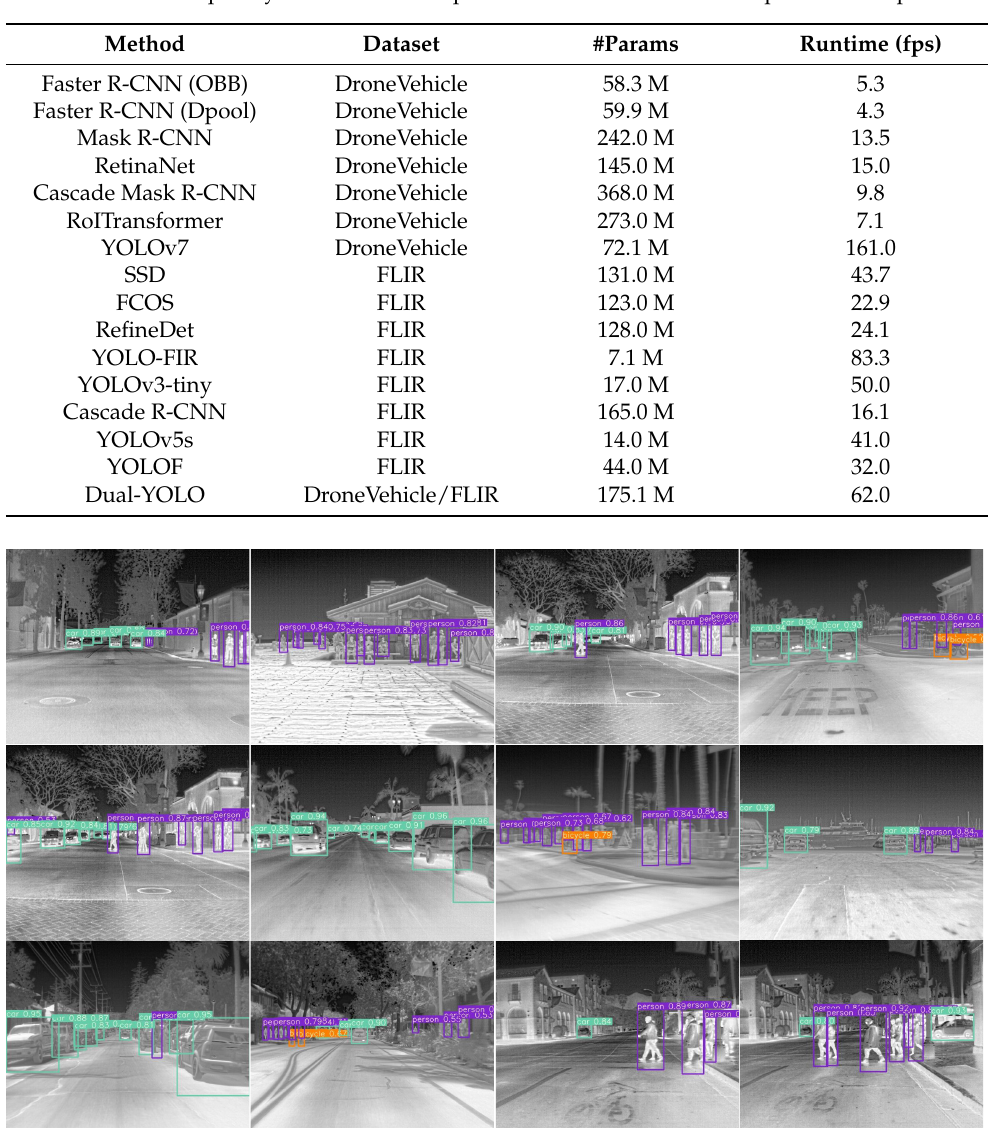
Figure 7. Visualization of Dual-YOLO detection results on the FLIR